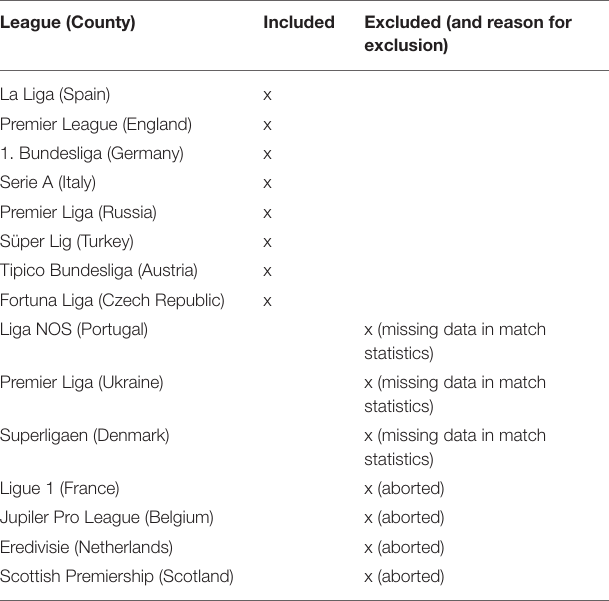
TABLE 1 | Overview of the included and excluded